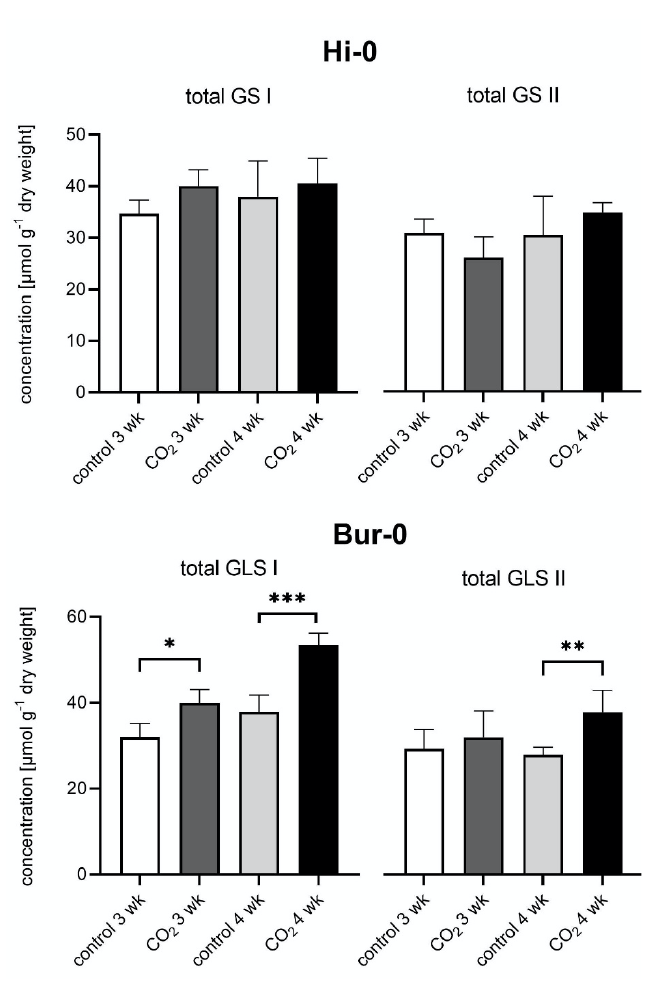
Fig. S1: Changes in total glucosinolate (GLS) levels in Arabidopsis thaliana Hi-0 and Bur-0 after CO 2 treatment for three or four weeks (wk). Averages and standard deviations of biological replicates (n = 4-5) are shown for two experimental replications (I and II) separately. Significant differences are marked with an asterisk (*, p < 0.05; **, p < 0.01; ***, p < 0.005; ; unpaired t -test).